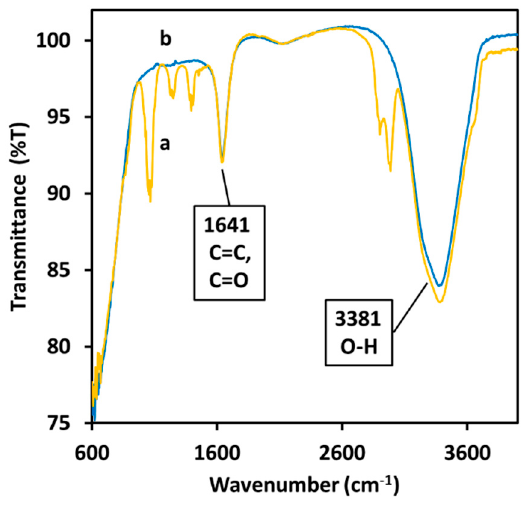
Figure 5. FTIR (Fourier-transform infrared spectroscopy) analysis of 10.6 µ M curcumin in water ( a ) and of a dispersion of Cur-AgNPs in water ( b ).